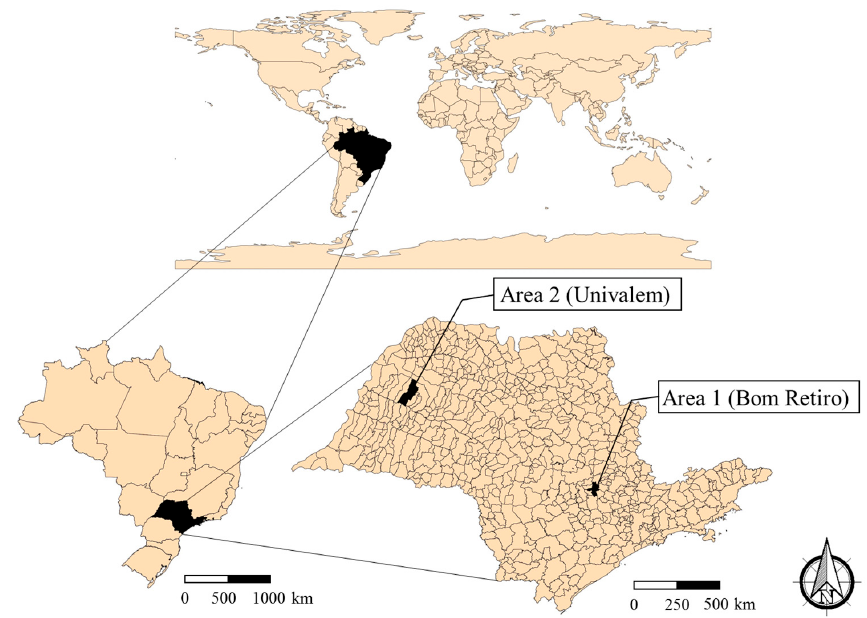
Figure 1. Geographical location of the experimental areas used in the study.